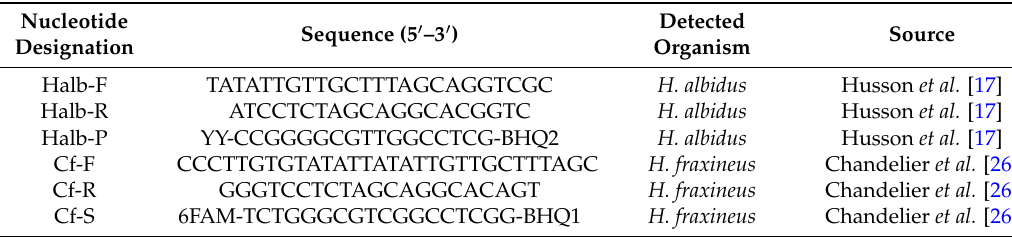
Specific primers and probes used in this study, species amplified, and reference of their